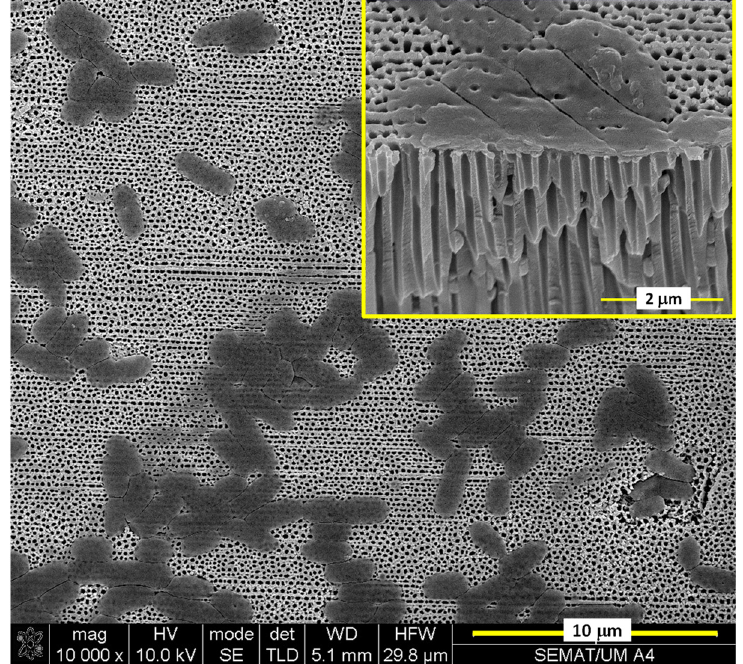
Figure 15. SEM micrograph showing Escherichia Coli microorganisms on the surface of the B1 touch sensor’s nanotextured Au top electrode.